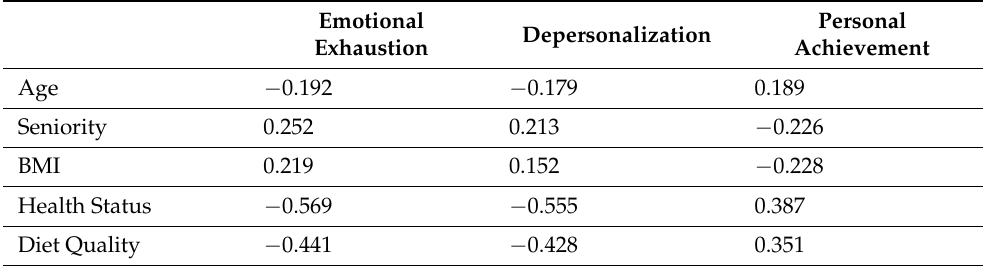
Table 4. Correlation of age, seniority, BMI, self-perception of health status, and self-perception of diet quality, with three dimensions of Burnout Syndrome in Mexican police officers. Personal Emotional Depersonalization Achievement Exhaustion Age − 0.192 − 0.179 0.189 0.252 0.219